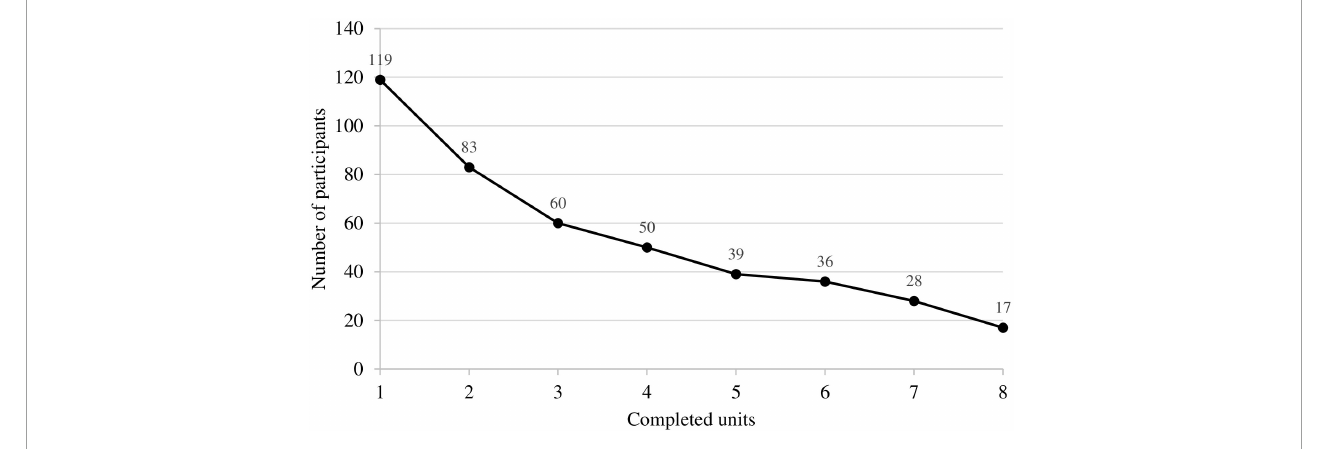
FIGURE1 Number of participants who completed the respective number of